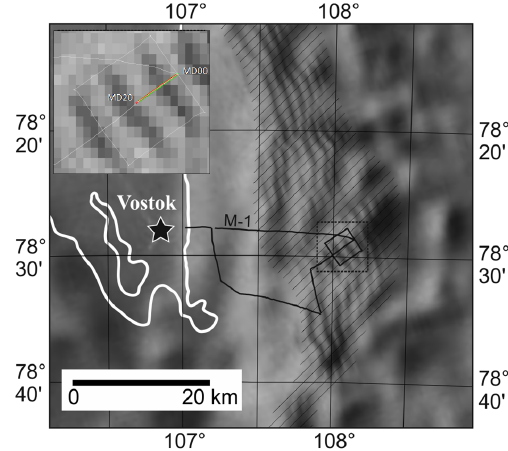
Figure 1. Vicinity of Vostok Station and the location of the study area. The megadunes are highlighted by hatching. Black line is the route of GPR and geodetic profiles. The location of the glaciologi- cal profile is shown in the insert (MD00-MD20). White line is the Vostok lake shoreline adapted from Popov and Masolov